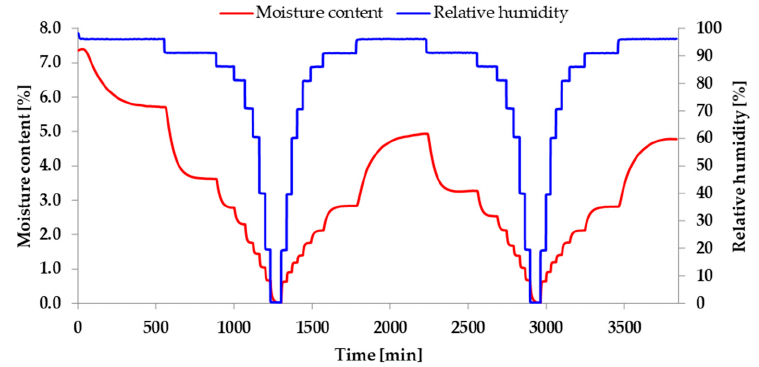
Figure 7. Sorption kinetic of the AC-4 sample at the first and second cycle.